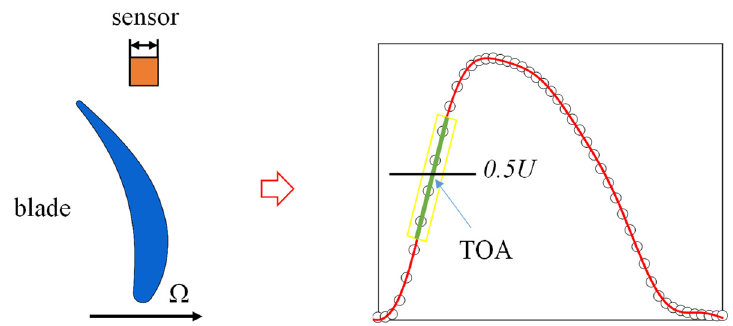
Figure 3. Method for obtaining blade tip arrival